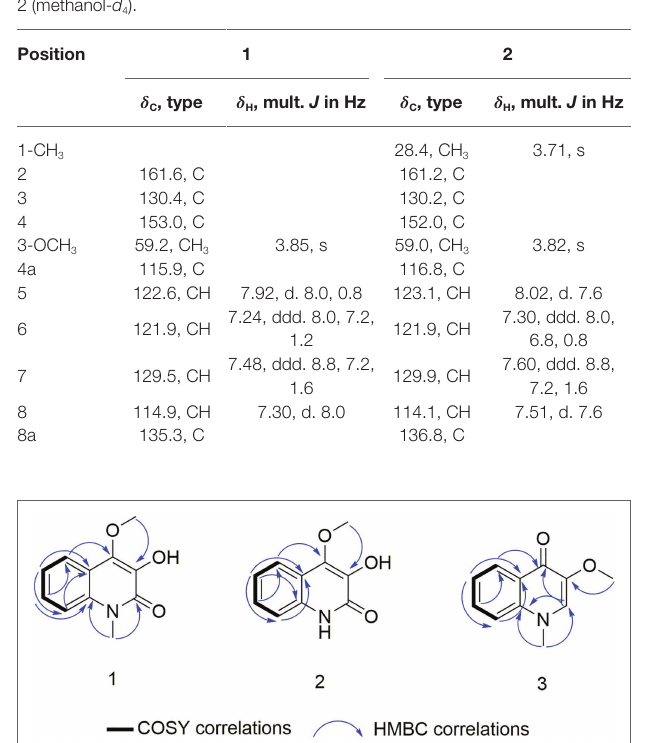
TABLE 6 | 1 H (400 MHz) and 13 C (100 MHz) NMR spectroscopic data for 3 (methanol-